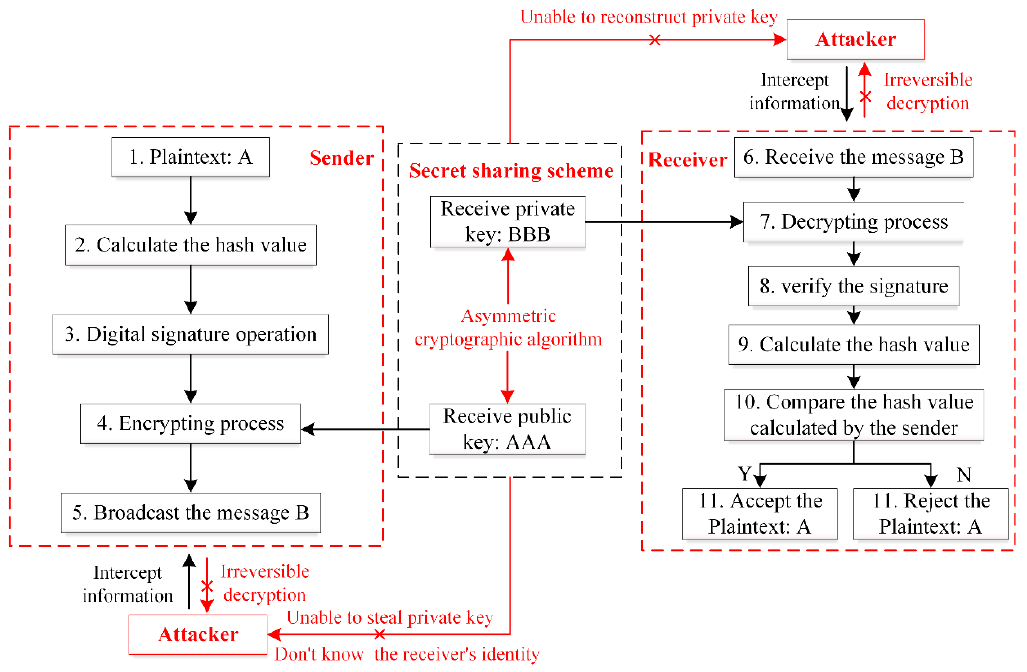
Figure 9. Flow chart of information protection in the blockchain.